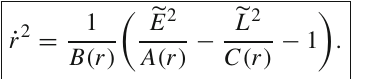
increases. Note that the throat radius has been set to b o = 1. a The plot shows how the proper length depends upon the radial coordinate r and the shape exponent n . b The plot shows how d r / d l varies with